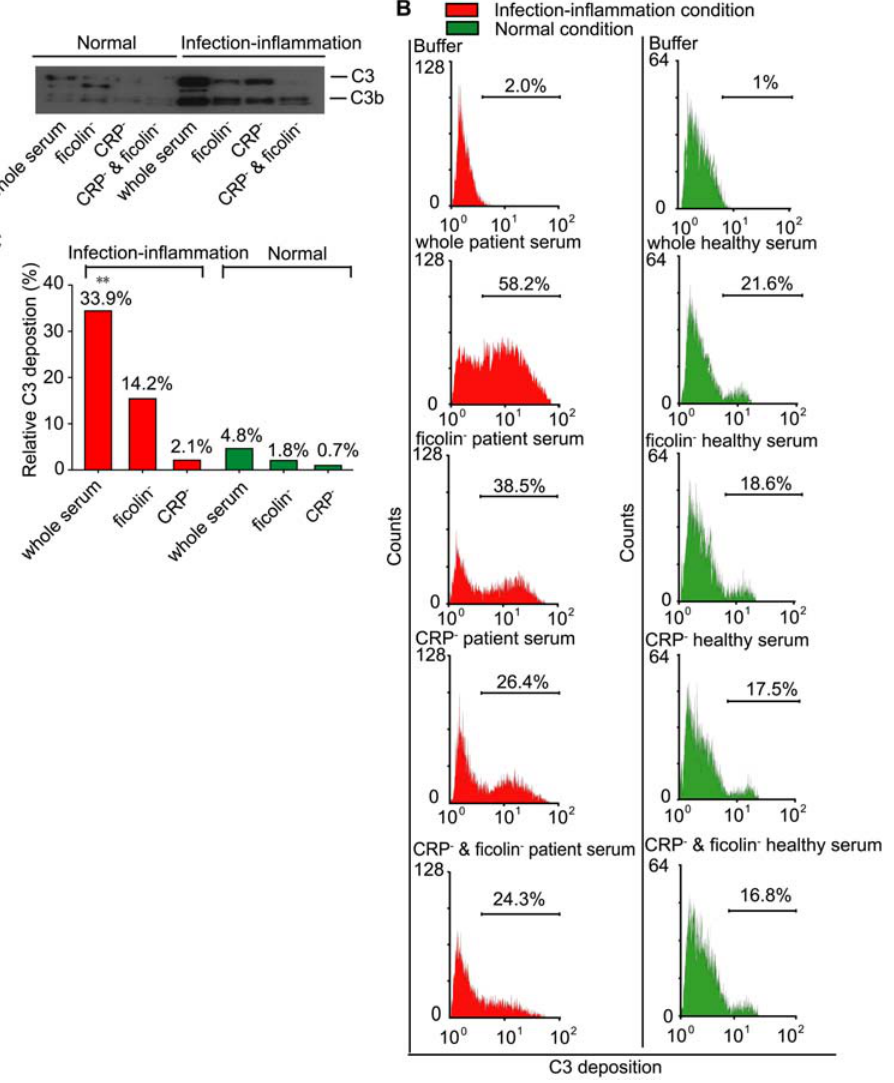
Figure 6. Crosstalk between CRP and ficolins generated more C3 deposition on the P.aeruginosa under the infection-inflammation condition. 10 8 cfu bacteria were incubated with whole serum, CRP-depleted (CRP 2 ), ficolins-depleted (ficolin 2 ), or CRP- and ficolin-depleted sera (CRP 2 & ficolin 2 ) under normal or infection-inflammation conditions. The bound proteins were detected by Western blot (A) and flow cytometry (B). In (A), the bound proteins were eluted with 0.5 M ammonium formate and detected by Western blot. In (B), after incubation with serum, the bacteria were stained with primary antibody (anti-C3d at 1:100) and secondary antibody (R-phycoerythrin-conjugated goat anti-rabbit at 1:100). The signal was collected using Cytomation Cyan LX. The percentage of the cells that shifted is indicated in the curves. (C) Quantification of the opsonized bacteria collected by flow cytometry under different conditions. The background reading was taken from bacteria incubated with CRP- and ficolin- depleted serum. The percentage of C3-deposition was calculated by subtracting the background reading and plotted together. **: P , 0.01 by student’s t test.